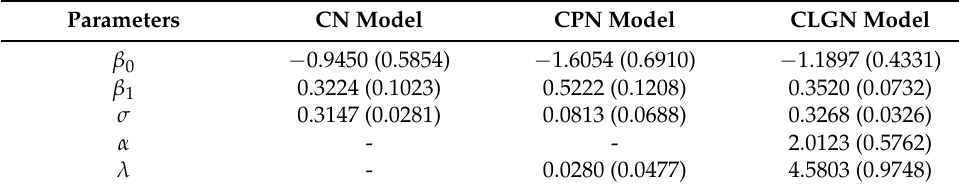
Table 6. Estimates (standard error) for CN, CPN, and CLGN linear models.